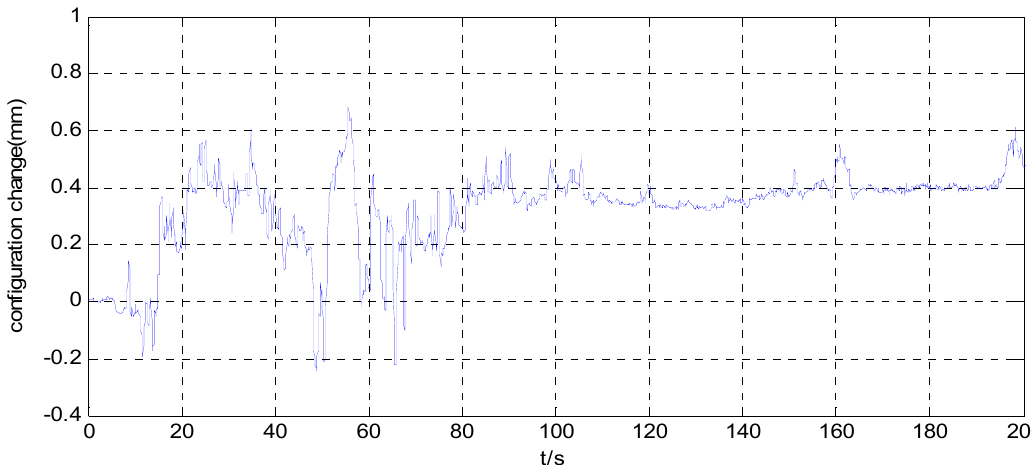
Figure 8. Relative angle error inside the simulator when θ z ( 0 ) = 6.85 ◦ .